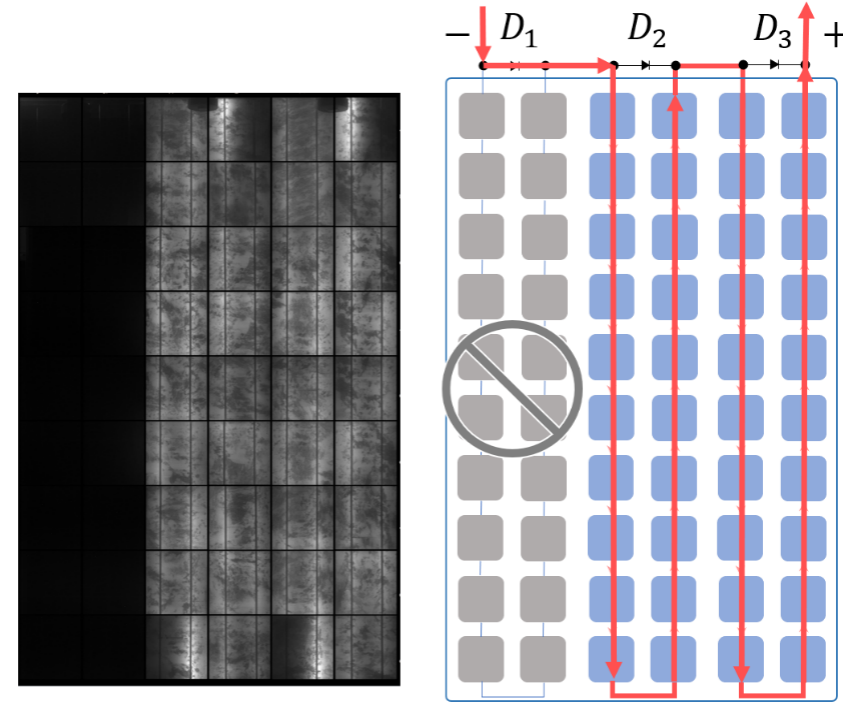
Figure 5. EL image and current flow of RSB hotspot module (205A).